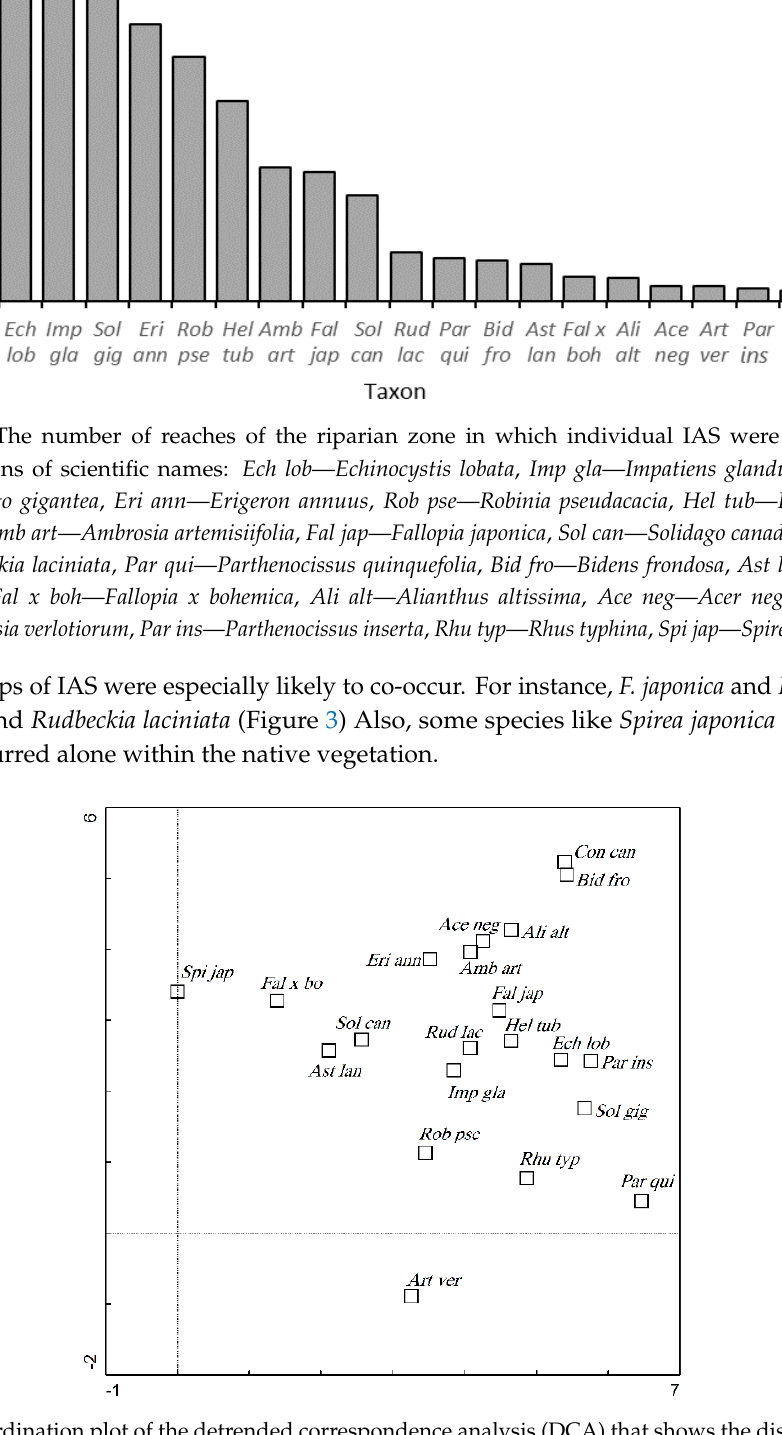
Figure 3. Ordination plot of the detrended correspondence analysis (DCA) that shows the distributions of the individual IAS (excluded: four species in only one section, Commelina commensis and Asclepias syriaca in only two sections) (for abbreviations see caption of Figure 2).